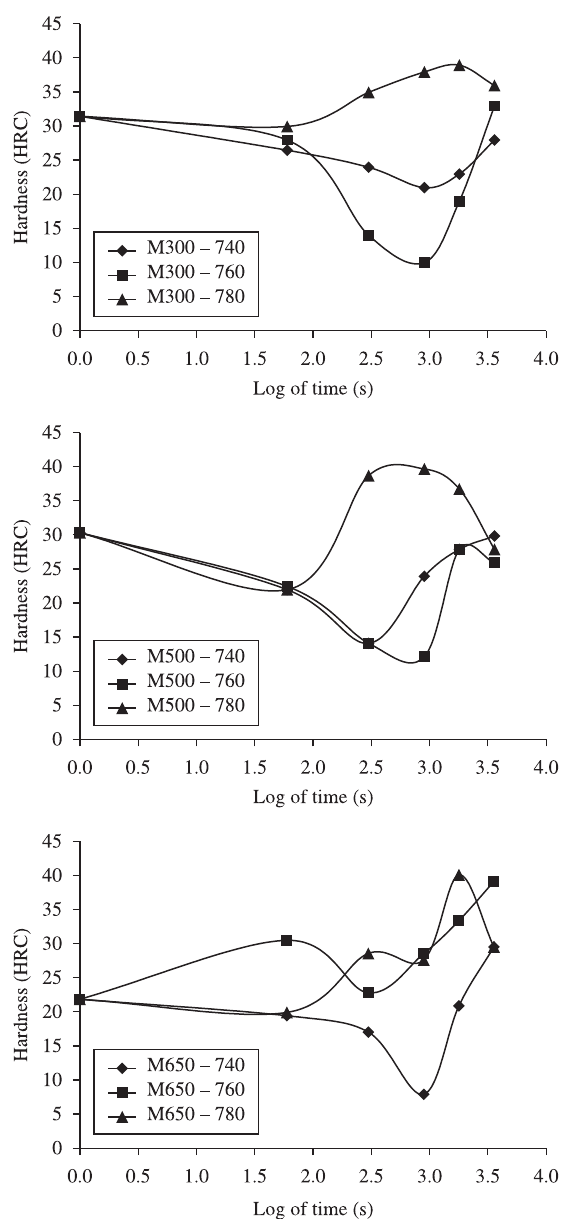
Figure 5. Variation of hardness with intercritical temperature for: a) M300 specimens, b) M500 specimens and c) M650